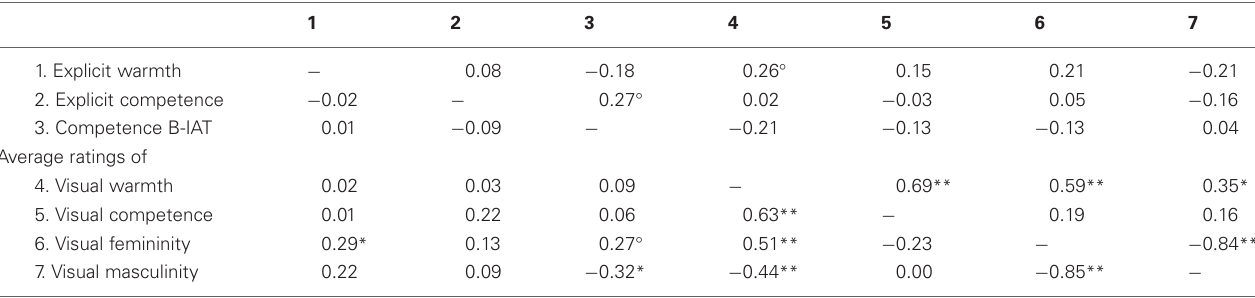
Table 1 | Correlations by condition of explicit stereotypes for relevant occupation group, implicit associations with competence, and independently rated warmth, competence and gender typicality of individual